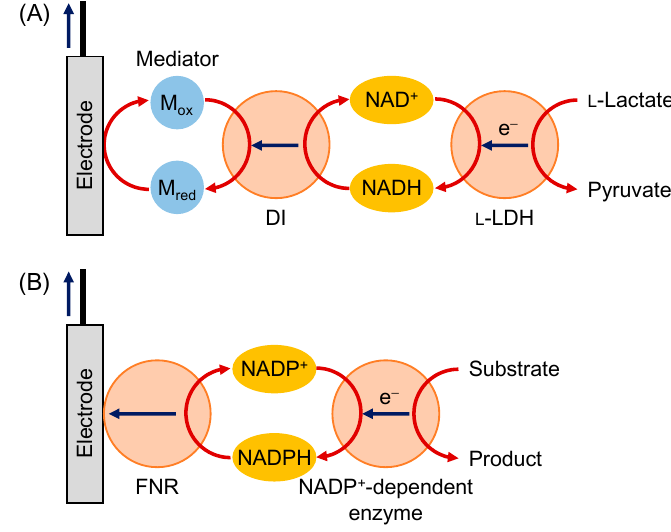
Figure 2. ( A ) Schematic view of MET-type bioelectrocatalysis of L -lactate dehydrogenase ( L -LDH) and FMN-containing diaphorase (DI); ( B ) schematic view of bienzymatic bioelectrocatalysis using an NADP + -dependent enzyme and ferredoxin-NADP + reductase